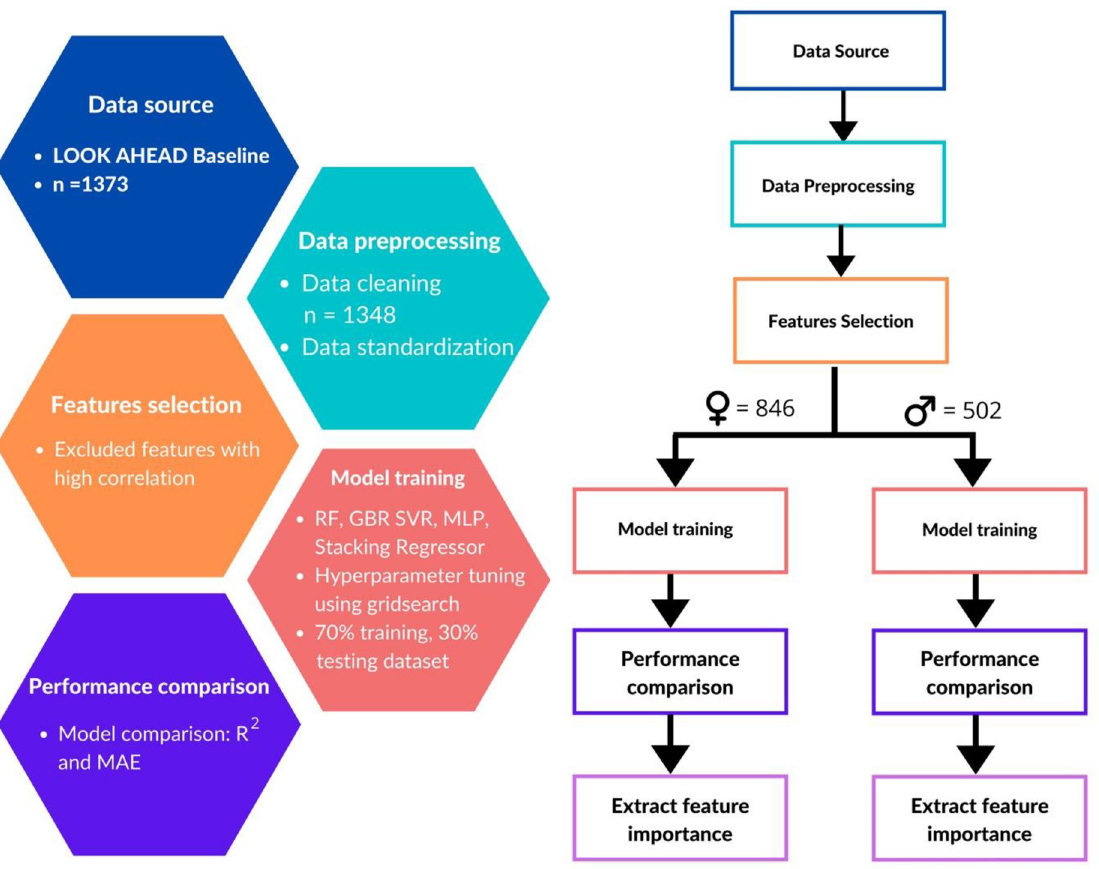
Fig 1. Methodology for the entire study. Abbreviations used are: n, the number of subjects; RF, Random forest; GBR, Gradient boosting regressor; SVR, Support vector regressor; MLP, Multilayer perceptron; R2, coefficient of determination; MAE, Mean absolute error.